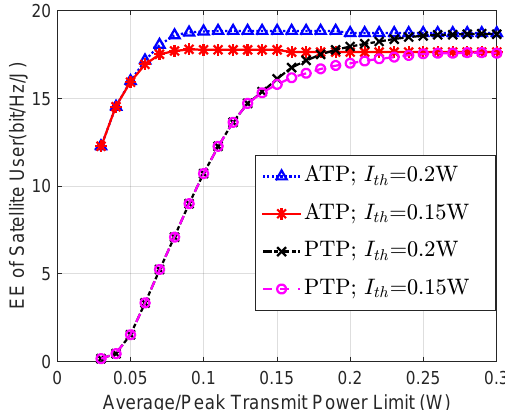
Figure 5. The EEs of the satellite user versus transmit constraint limits for different I th with m I = 1 and Ω I = 1.